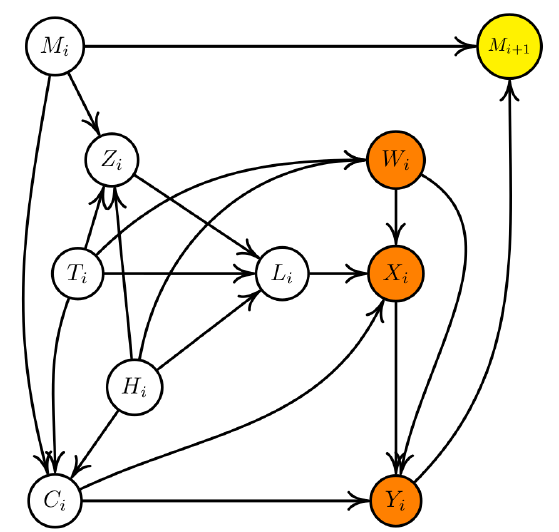
Figure 1. Causal DAG for Plasmopara viticola infection at time interval i = 1. Random variables are associated with nodes of the graph; arrows such as C i −→ Y i indicate causal relationships, i.e., C i determines Y i . Orange-dark-grey background nodes pertain to the last 3 days within time interval i . The white background nodes are quantified in the first 4 days of i . The yellow-light-grey node M i + 1 is the only variable in this DAG belonging to the next time interval i + 1. Dependencies on variables in time intervals i − 1 are not